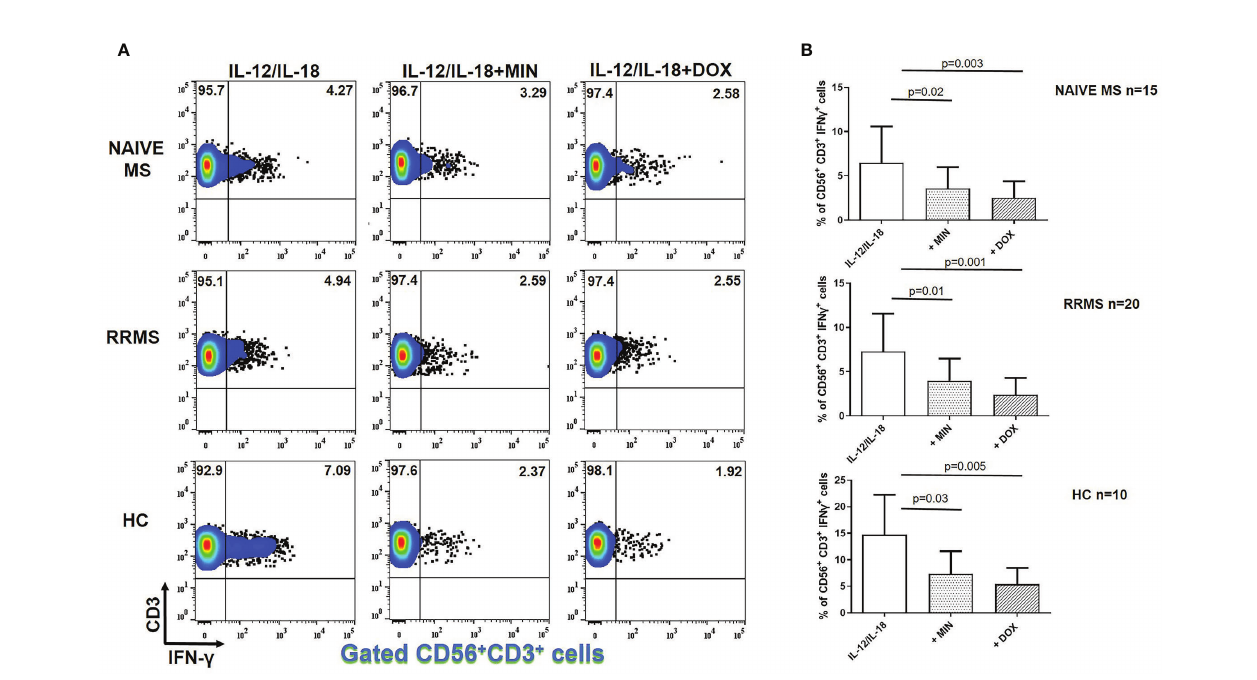
FIGURE 3 | Tetracycline-mediated inhibition of CD56 + CD3 + IFN- g + T cells. PBMCs from naïve MS patients (n=15), RRMS patients (n=20) and HCs (n=10) were seeded in cell culture plates (1 x 10 6 per well) and stimulated with IL-12 plus IL-18 (IL-12/IL-18), IL-12/IL-18 plus minocycline (MIN) and IL-12/IL-18 plus doxycycline (DOX) for 5h. Cells were collected, washed, surface stained with appropriate monoclonal antibodies an analyzed for intracellular IFN- g production by fl ow cytometry (see also methods section). Individual cell subsets were sub-gated according to expression of CD3 and CD56 surface epitopes. (A) Flow cytometry dot-plots showing the frequency of IFN- g + NKT cells (gated CD56 + CD3 + cells two-dimensionally depicted in CD3 vs IFN- g plots) in IL-12/IL-18, IL-12/IL-18/MIN and IL-12/IL- 18/DOX treated cells from representative MS cases. (B) Box and whiskers graphical representation showing signi fi cant reduction in the percentages of IFN- g - producing NKT cells in the presence of tetracyclines in naïve MS, RRMS and